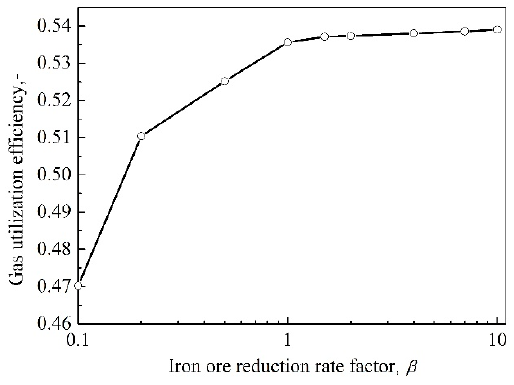
Figure 7. The relationship between the gas utilization efficiency and iron ore reducibility.